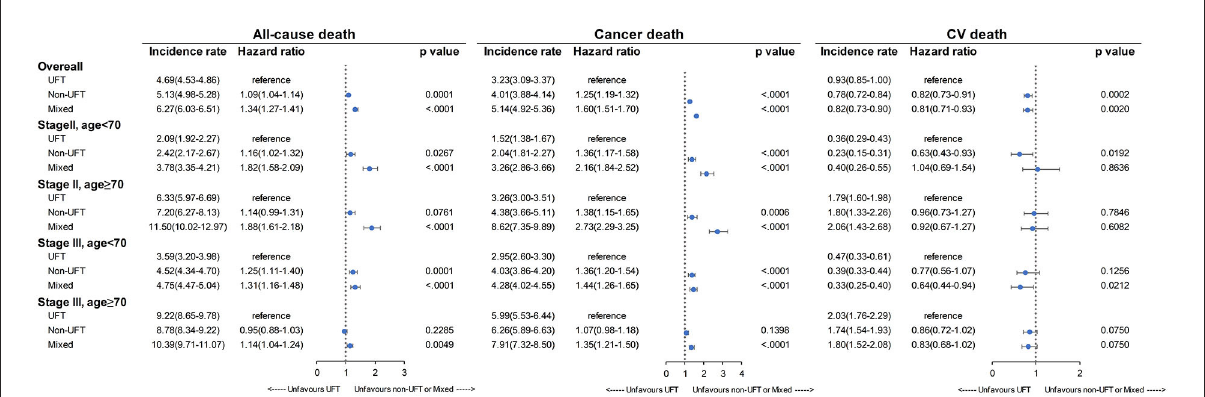
FIGURE5 Mortality rate among patients with stage II–III colorectal cancer after SIPTW subgroup analysis (SIPTW, stabilized inverse probability of treatment weighting using propensity score; UFT, fluoropyrimidine).